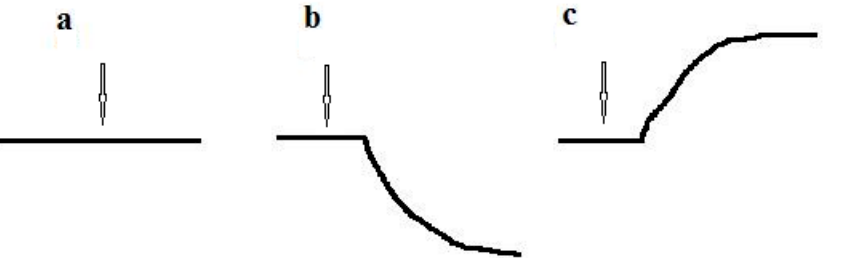
Figure 2. Analytical signal of the biosensor: ( a ) Basic endogenous respiration of culture-receptor cells in the absence of a substrate; ( b ) Response of culture-receptor cells to substrate, when cells’ respiration is activated after substrate injection; ( c ) Response of culture-receptor cells to substrate, when cells’ respiration is inhibited after substrate injection. The arrow shows the moment of sub- strate injection.